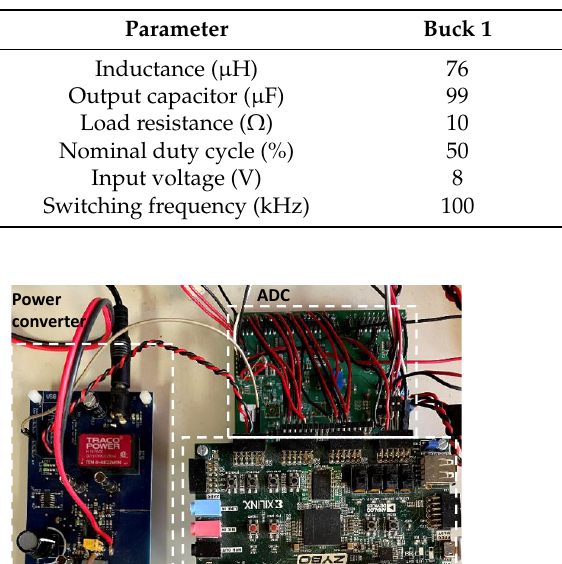
Table 1. Prototypes’ data.